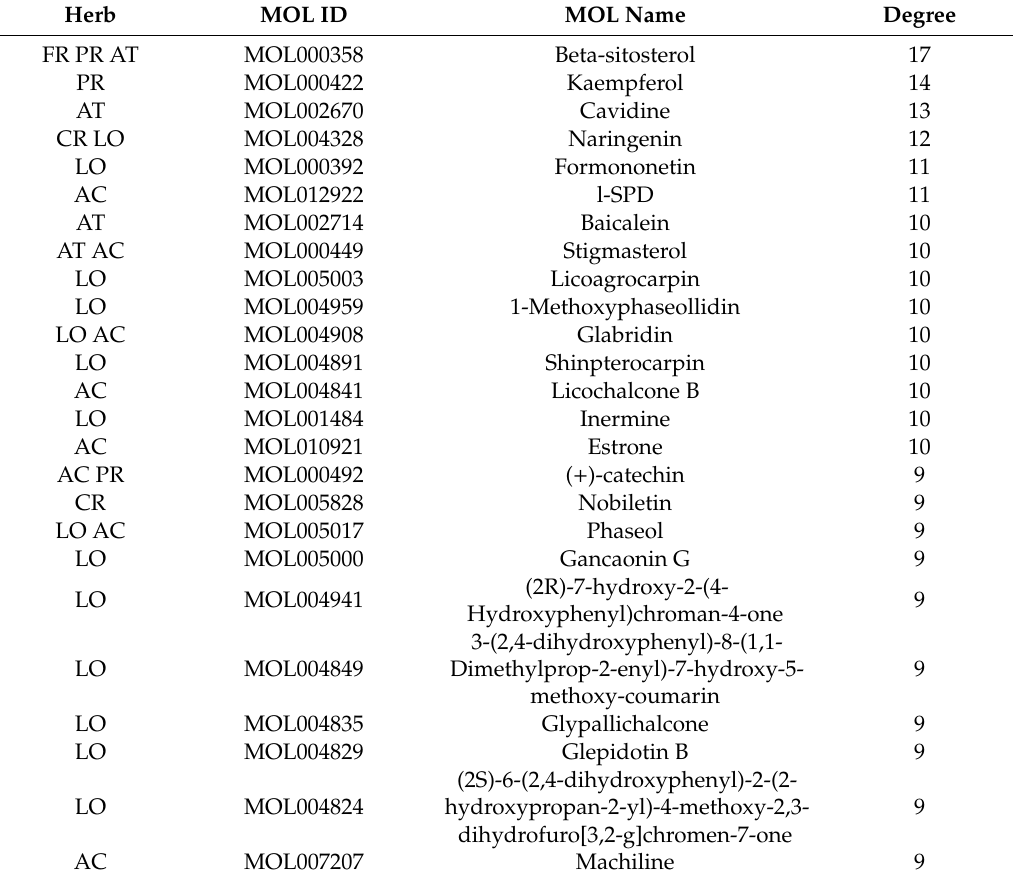
Figure 3. The shapes of different colors represent different types of nodes. Blue ellipse represents traditional Chinese medicine, green square represents chemical composition, orange triangle represents the predictive target of XQD, red triangle represents the direct target of XQD for lung cancer treatment, and light blue represents the indirect target of XQD for LC treatment. Table 4. Key components of XQD for lung cancer (LC)